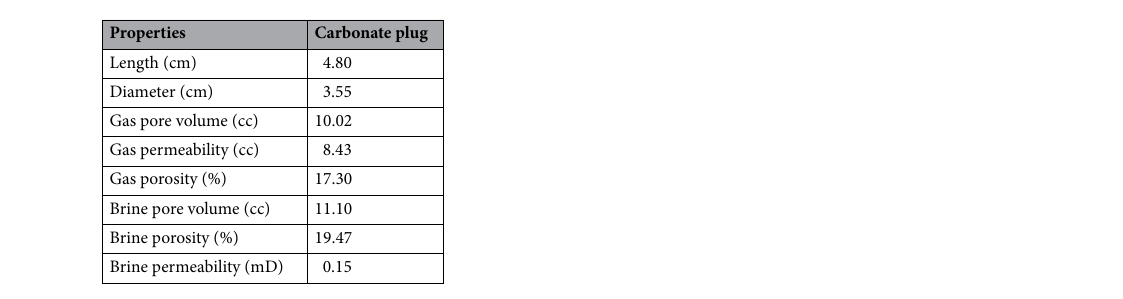
Table 2. Properties of plug for performing dynamic CO 2 tests.